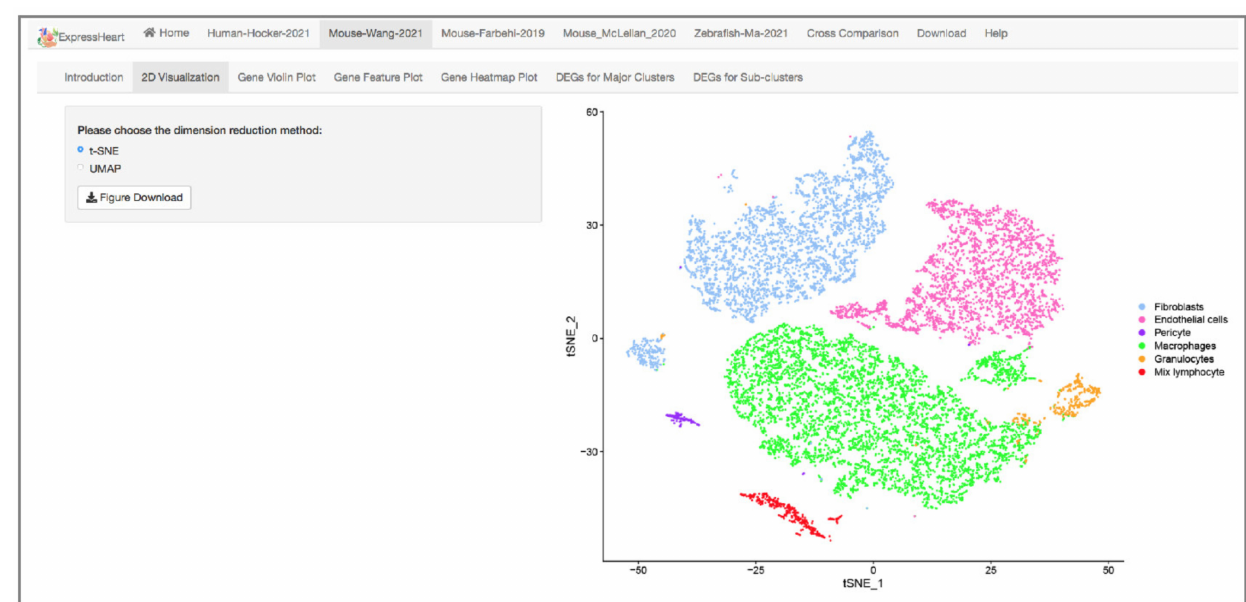
Figure 2. Interface of 2D visualization via UMAP/t-SNE for the Mouse-Wang-2021 dataset. On the left panel, users can choose different dimension reduction methods; the corresponding 2D UMAP/t-SNE plot is presented on the right. Each dot represents a cell/nucleus, and different colors correspond to different cell